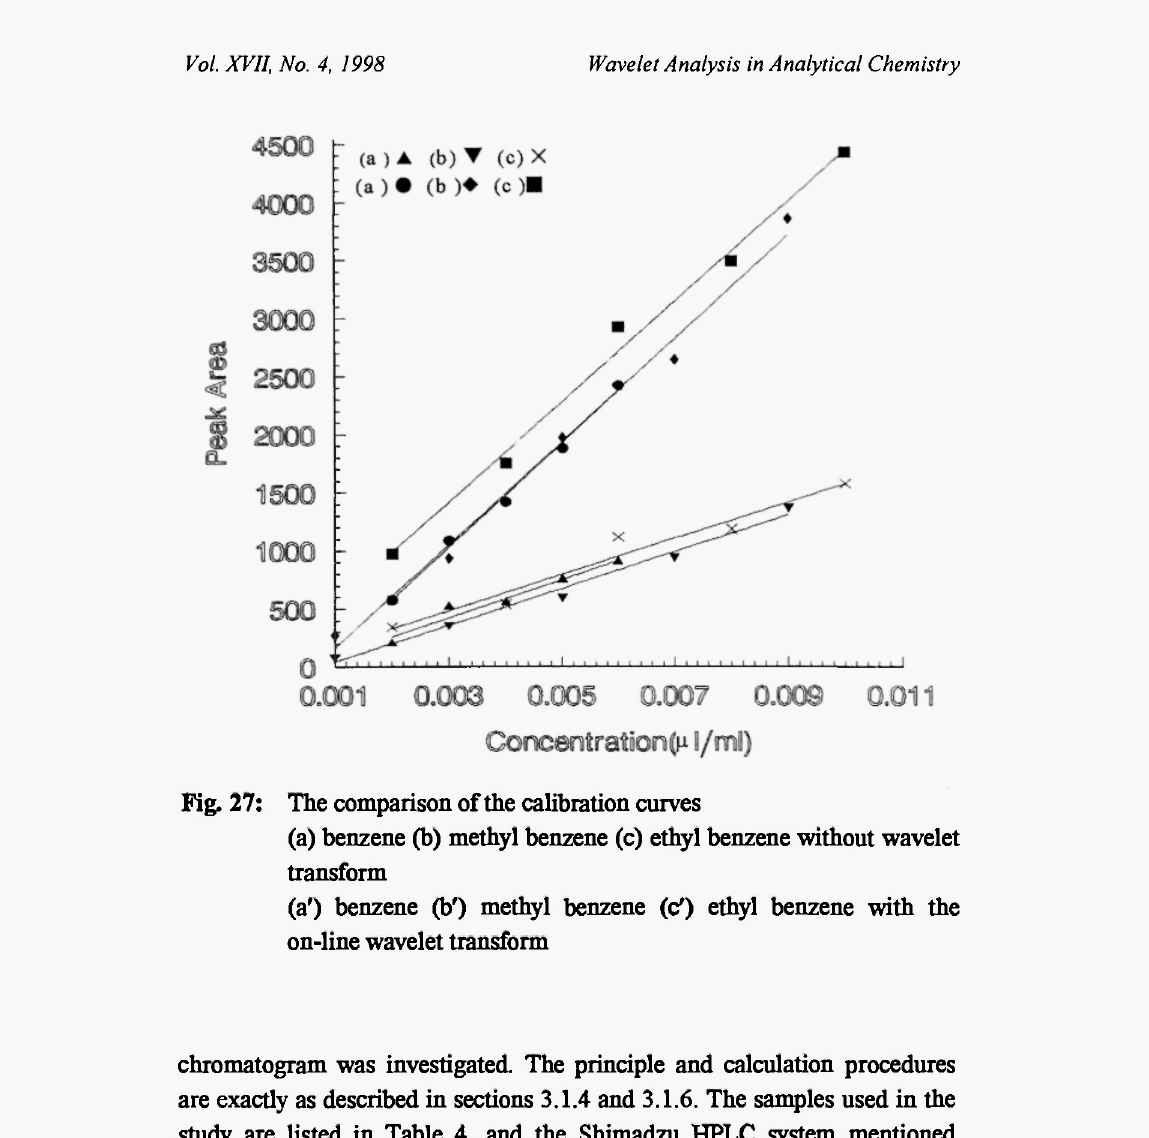
Fig. 27: The comparison of the calibration curves (a) benzene (b) methyl benzene (c) ethyl benzene without wavelet transform (a') benzene (b') methyl benzene (cf) ethyl benzene with the on-line wavelet